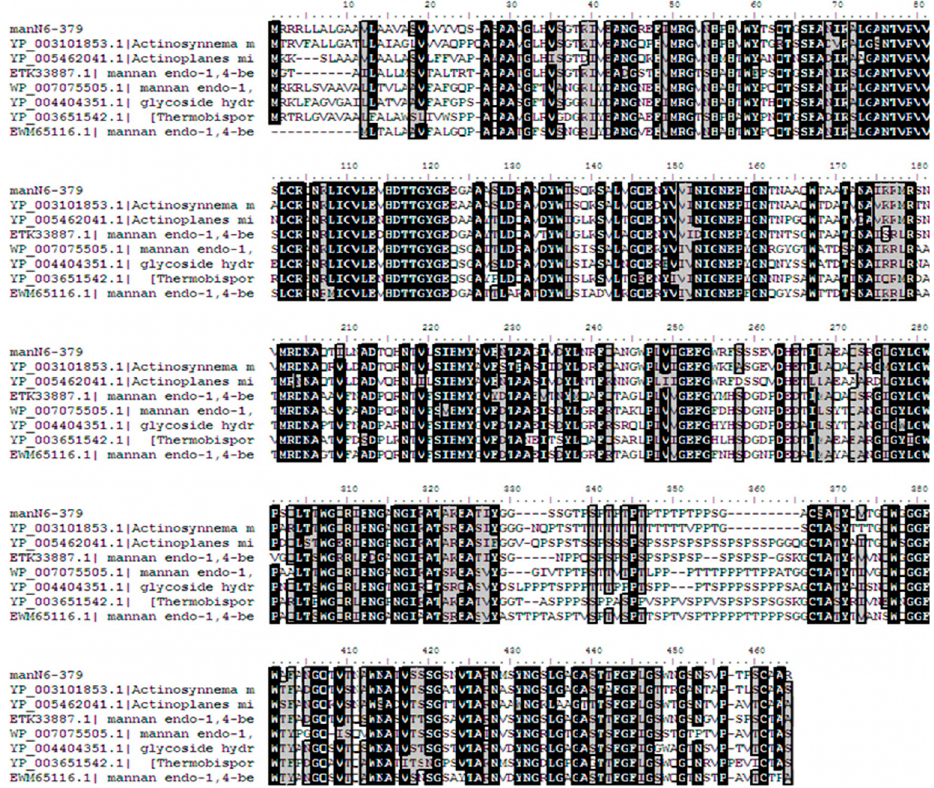
Figure 2. Amino acid sequence alignment of mannan endo- β -1,4-mannanase from N. jabiensis ID06-379 and related actinomycetes . Multiple sequence alignment was completed by CLUSTAL W [Bioedit]. Percent similarities of endo-1,4- β -mannanase from N. jabiensis ID06-379 (GenBank accession no. DDBJ LC012036) to other enzymes were 77% for A. mirum (GenBank accession no YP_003101853.1), 69% for Actinoplanes globisporus (GenBank WP_020515925.1), 68% for A. missouriensis (Genbank accession no. YP_005462041.1), 65% for Microbispora sp. ATCC PTA-5024 (GenBank accession no. ETK33887.1), 60% for Micromonospora sp. ATCC 39,149 (GenBank accession no. WP_007075505.1), 59% for Verrucosispora maris AB-18-032 (GenBank accession no. YP_004404351.1), 61% for Thermobispora bispora DSM 43,833 (GenBank accession no. YP_003651542.1), and 60% for Micromonospora sp. M42 (GenBank accession no. EWM65116.1). Identical residues are highlighted in